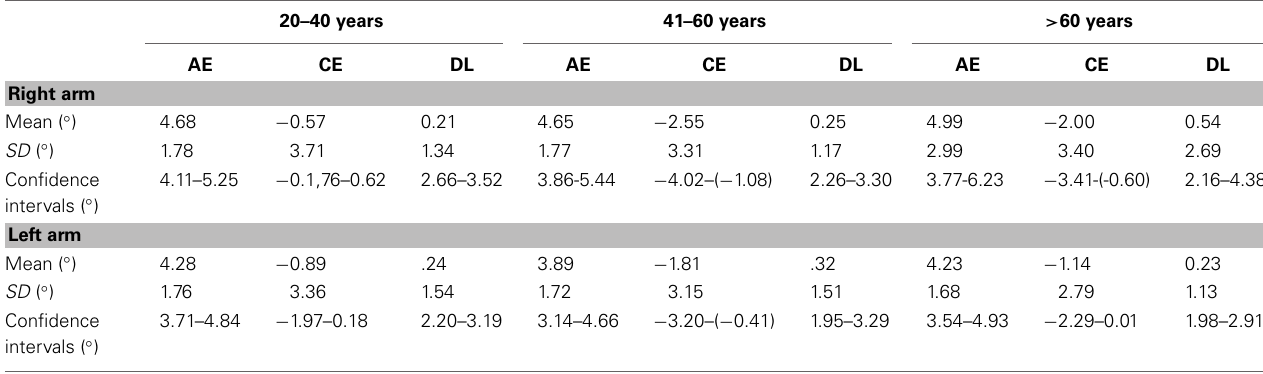
Table 2 | Summary of the normative data for APS measured with the APD for both arms, separately for the three age groups and the